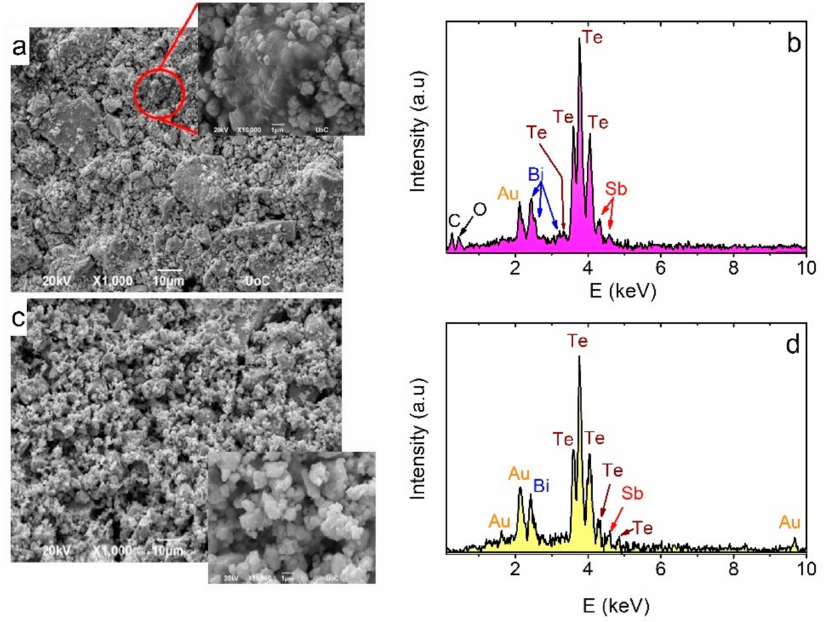
Figure 3. ( a ) Scanning electron microscopy (SEM) micrograph for BST (x = 0.4)/ABS foil (cid:16)